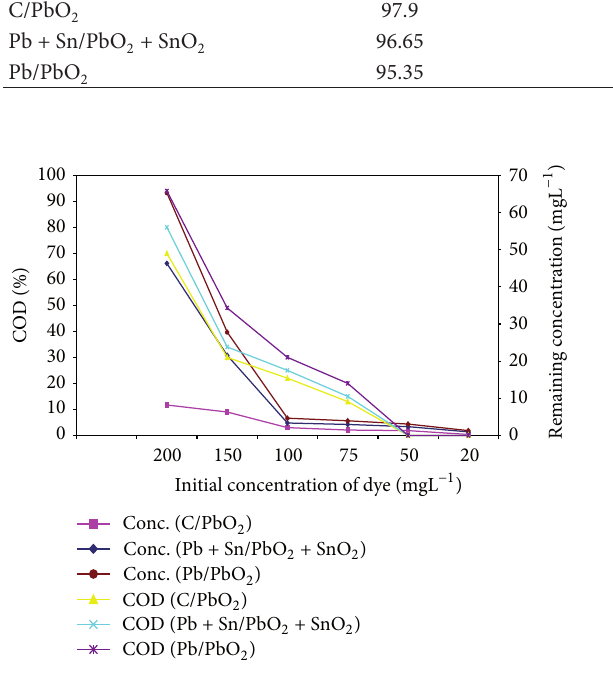
, Pb + Sn/PbO + SnO , and Pb/PbO electrodes in the optimum 2 2 2 2